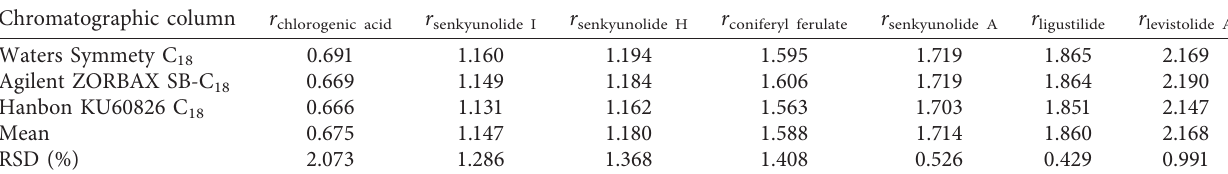
Table 3: Relative retention values (ri/s) of 7 components to be tested and ferulic acid determined by different chromatographic columns.